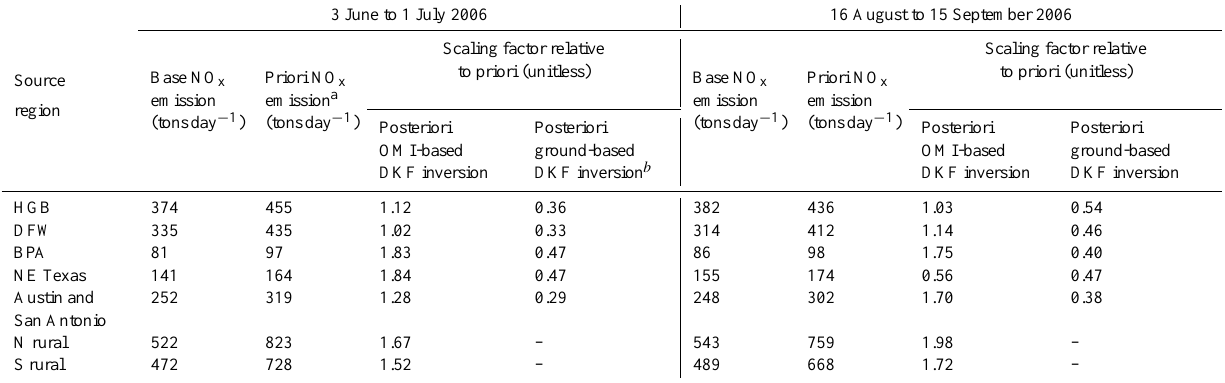
Table 2. Scaling factors for each region from different inversions.